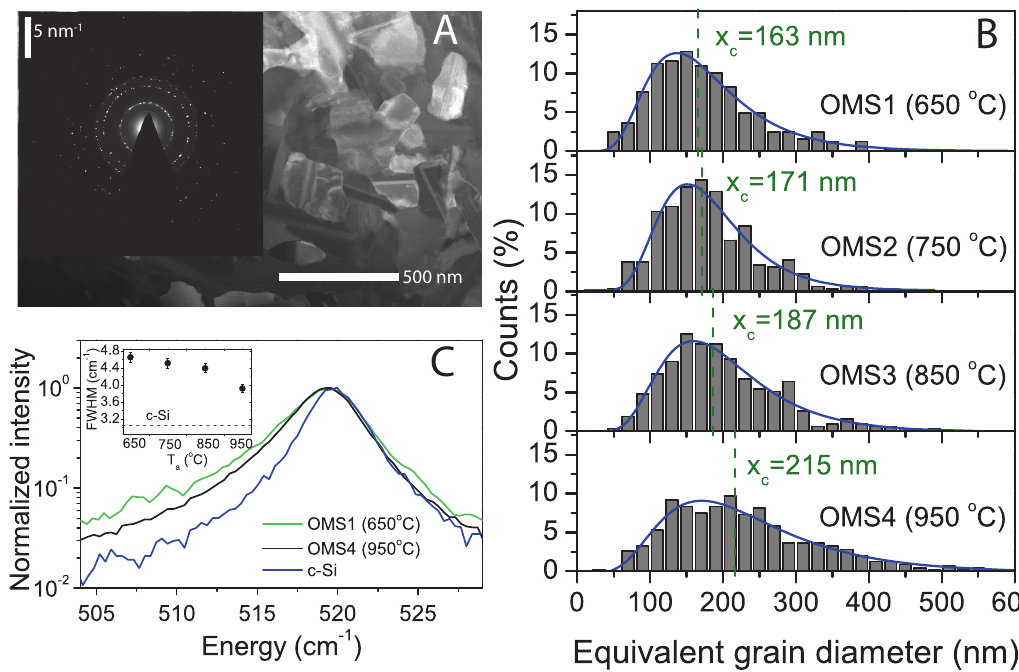
Figure 1: Nanocrystallite size distribution in the nc-Si films. (A) Bright-field TEM image of the sample OMS4, showing the randomly oriented nanocrystallites. The inset shows a selective area electron diffraction(SAED)imageofthesample.(B)Histogramsofthecrystallitesizedistributionofsamplesannealedatdifferenttemperatures T a .The analysis includes more than 500 nanocrystallites in each sample, and a log-normal distribution is used to fi t the histograms. The average nanocrystallite size ( x c ) is shown by the vertical dashed black lines; (C) Raman scattering spectra of the reference c-Si (blue) and the nc-Si layers annealed at 650 and 950 ° C (green and black, respectively). The full width at half maximum of the Raman peak as a function of the annealing temperature is shown in the inset. The dashed horizontal line corresponds to the value measured from the c-Si reference sample. TEM, transmission electron microscopy; nc-Si, nanocrystalline